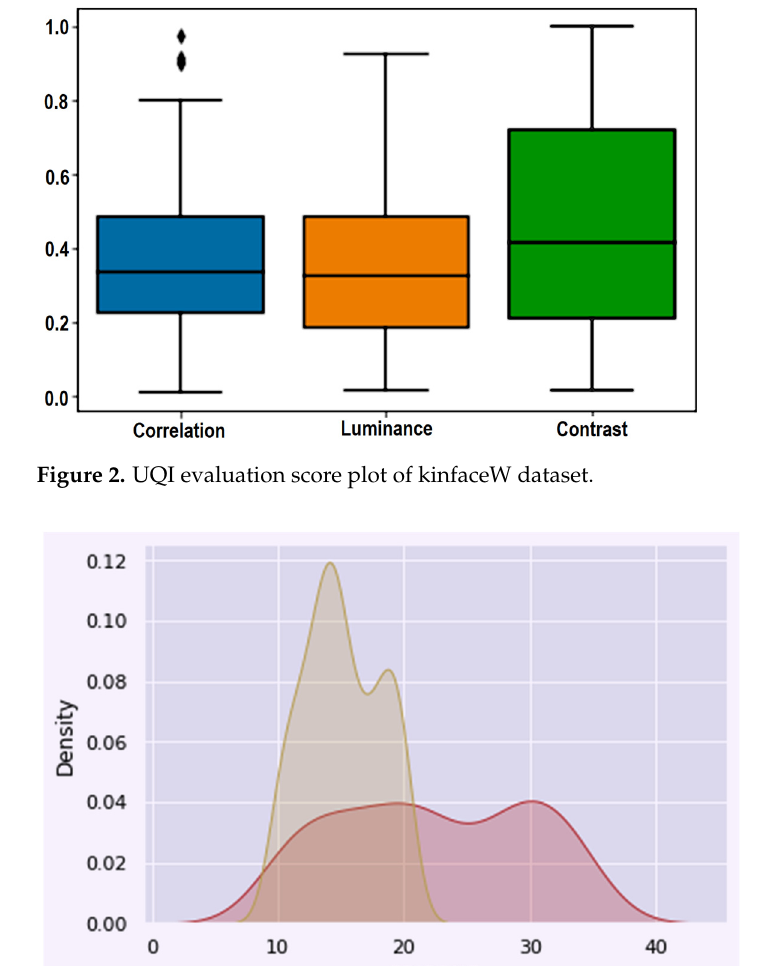
Figure 2. UQI evaluation score plot of kinfaceW dataset.